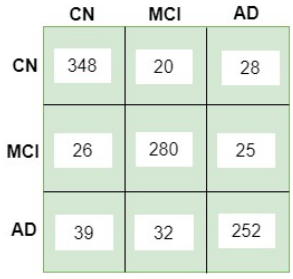
Figure 4. Confusion